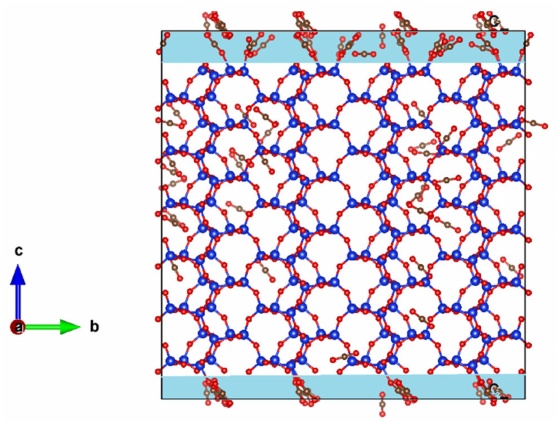
Figure 8. Snapshots in X–Z plane from the simulation of CO 2 in ZSM-22 with empty space inserted in the Z-direction. Blue, red, and gray spheres respectively represent Si, O, and C atoms. More CO 2 molecules can be seen strongly adsorbed on the surface of ZSM-22 in the inter-crystalline space (shown in light blue) as compared to inside the